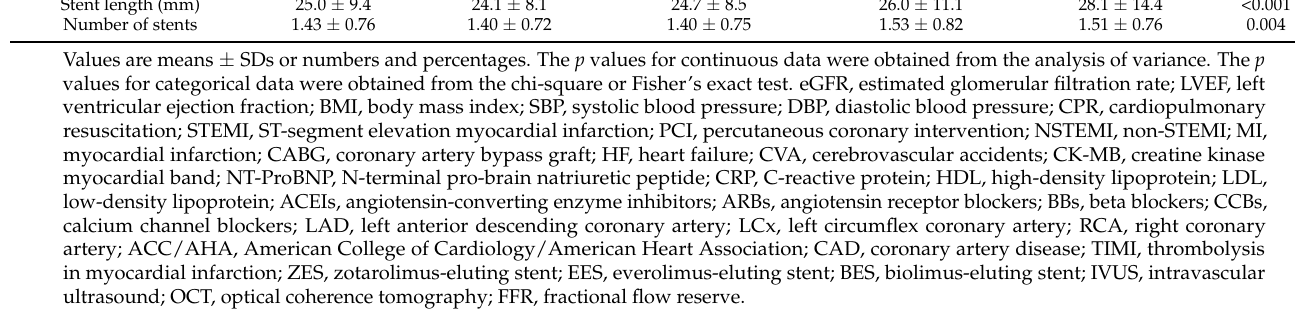
Table 3. Baseline characteristics between statin users and nonusers